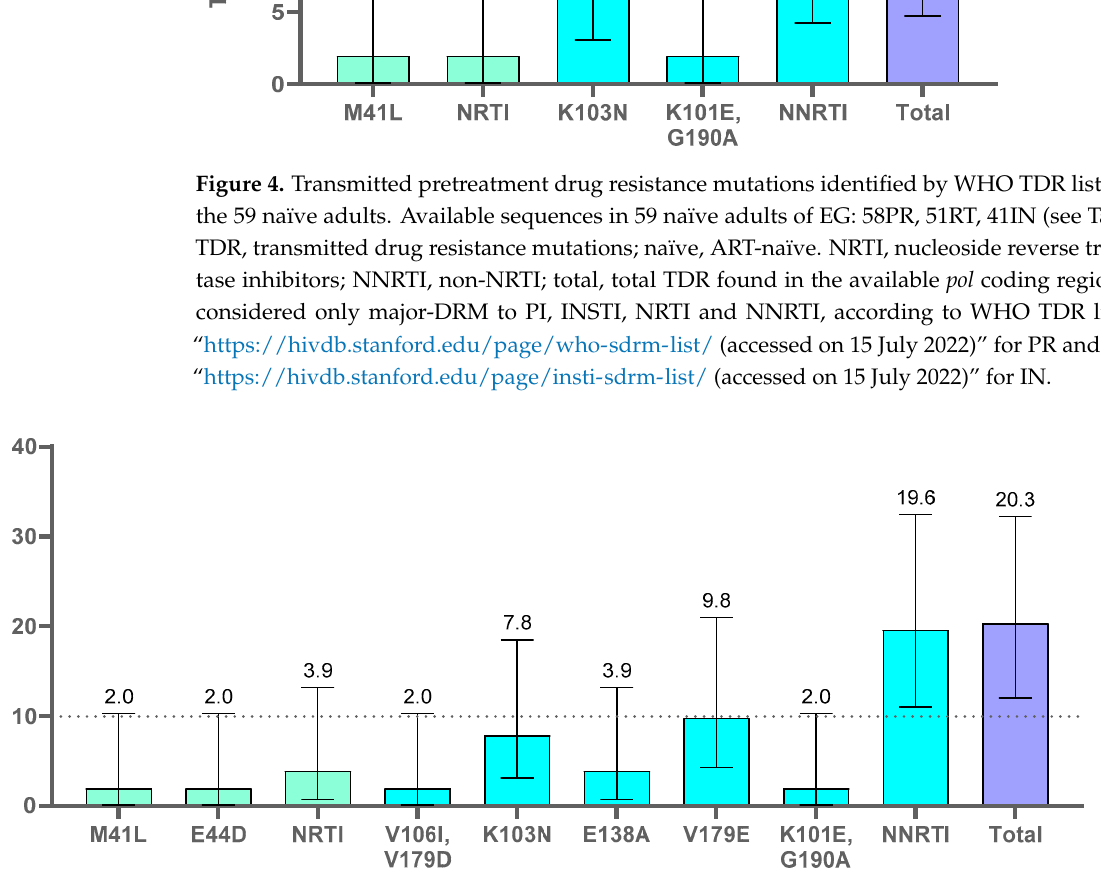
Figure 5. Transmitted pretreatment drug resistance mutations identified by Stanfordv9.0 in the 59 naive adults. Available sequences in 59 naïve adults of EG: 58PR, 51RT, 41IN (see Table S1). Percentages were calculated, excluding the two naïve children since they did not carry viruses with major or minor-DRM. TDR, transmitted drug resistance mutations; naïve, ART-naïve. NRTI, nucleoside reverse transcriptase inhibitors; NNRTI, non-NRTI; total, total TDR found in the available pol coding regions. We considered only major-DRM to PI, INSTI, NRTI and NNRTI, according to Stanford v9.0. DRM to IN E92K was not included in this figure as it appears in the APOBEC mutation list provided by Stanford “https://hivdb.stanford.edu/page/apobecs/ (accessed on 15 July 2022)” and it does not confer resistance to any antiretroviral.